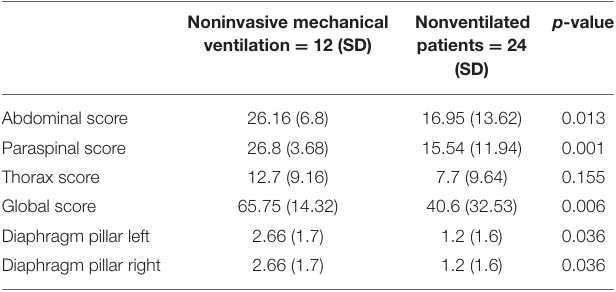
TABLE 2 | Mean values of the compound MRI scores at every visit. Visit 1, mean (SD) Visit 2, mean (SD) Visit 3, mean (SD)